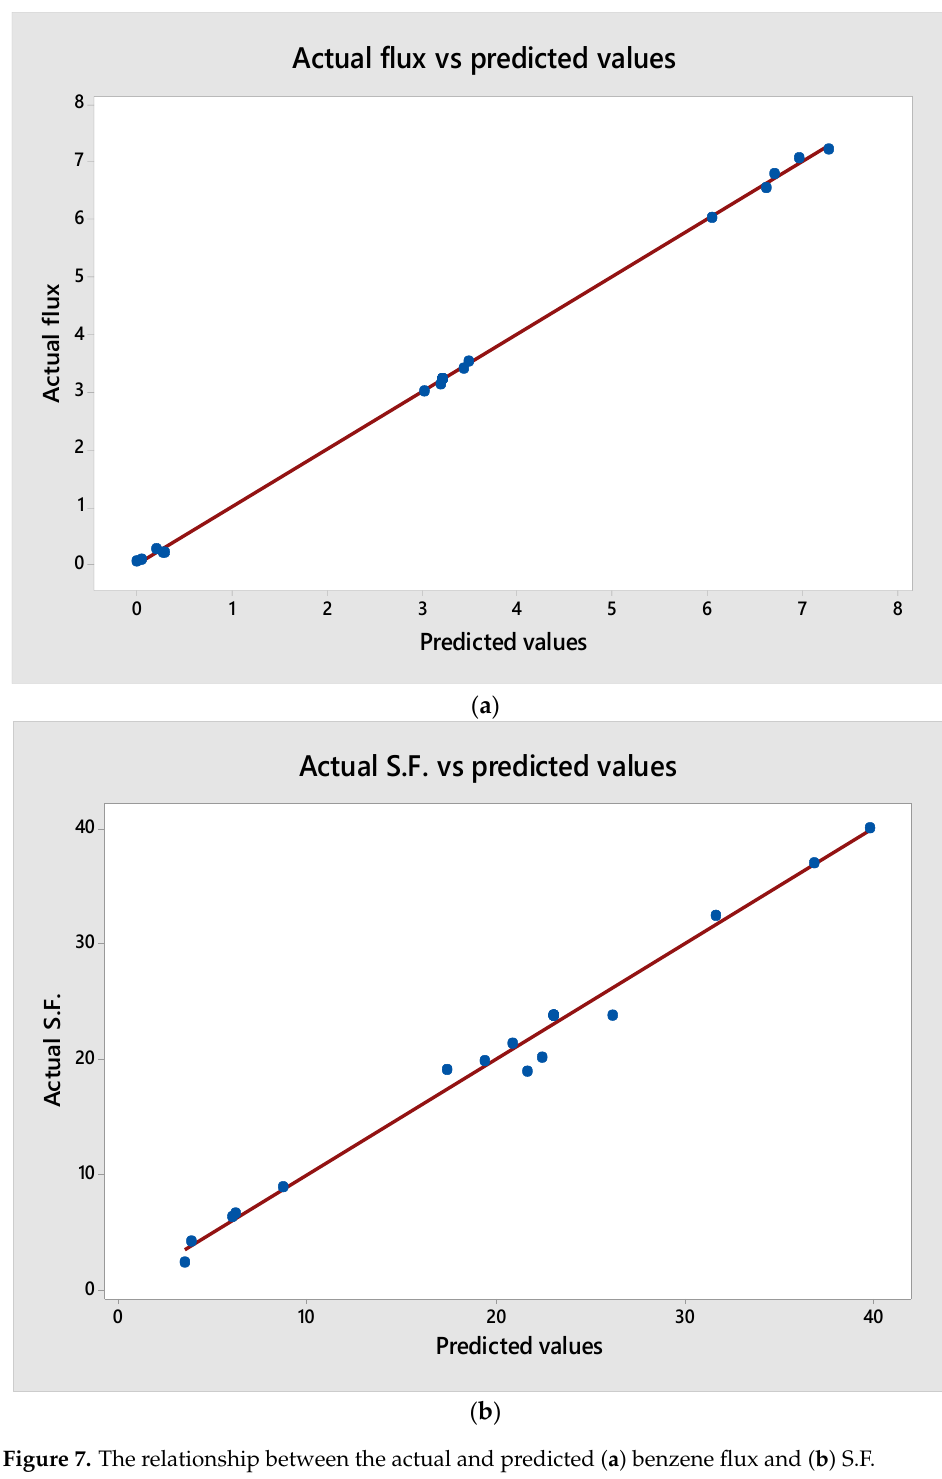
Figure 7. The relationship between the actual and predicted ( a ) benzene flux and ( b ) S.F. To fully quantify the significance of each factor, an analysis of variance (ANOVA) was calculated using Minitab 18. Tables 5 and 6 display the results of the ANOVA calculations for the benzene permeate flux and separation factor, respectively. On the other hand, the correlation coefficients (R 2 values) were found to equal 99.95 and 98.63 for the benzene permeation flux and separation factor, respectively, both of which are considered desirable. This reveals that about 99% of the data deviation can be described by the two empirical models [39].